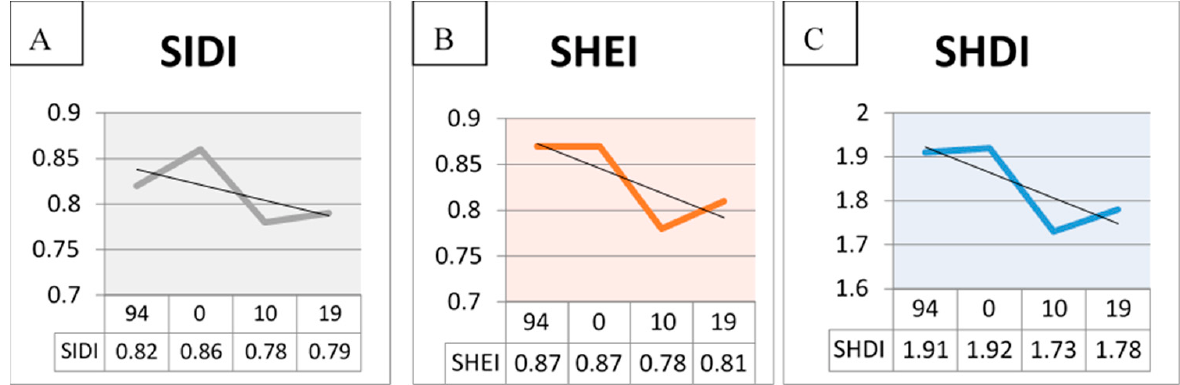
Figure 6. Diversity indices, the thick lines are the values of the indices in the different years, the thinner lines are the trend of each index. ( A ) Graph of Simpson’s Diversity Index, ( B ) Graph of Shannon’s Evenness Index, ( C ) Graph of Shannon’s Diversity Index. Table 6. Table of area, density and landscape aggregation metrics obtained by the FRAGSTAT software. Area, Density and Aggregation